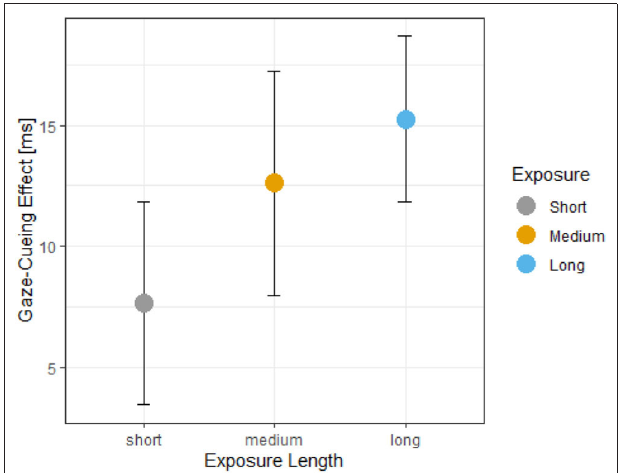
FIGURE 3 | Gaze-cueing effects (GCEs) as a function of exposure. The graph illustrates the mean values of GCE, which is the calculated difference between valid and invalid trials, with more positive values indicating stronger attention orienting in response to iCub’s gaze shifts. The GCEs show that attention orienting to gaze-cues is enhanced as the length of exposure (i.e., trial numbers) increased.